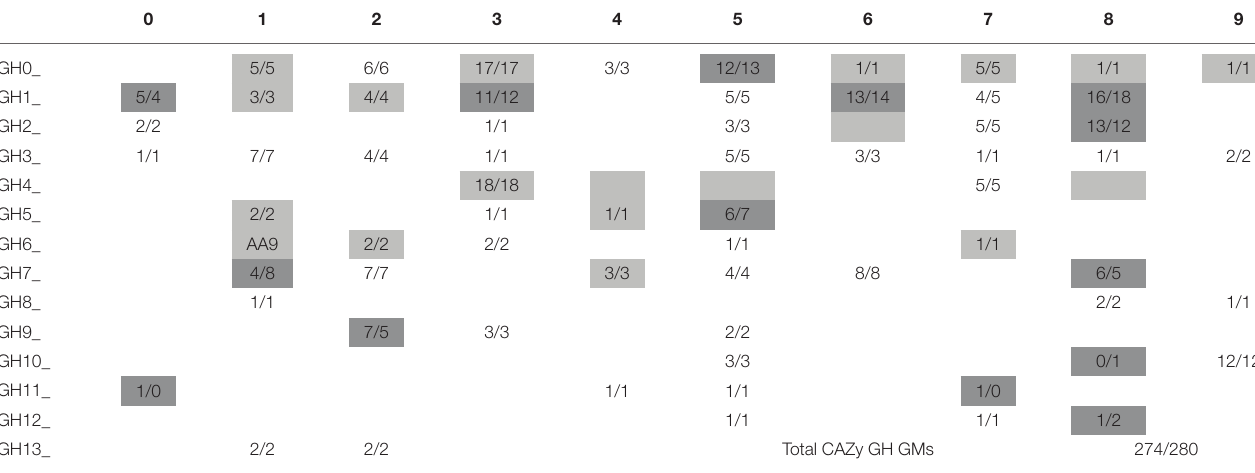
TABLE 7 | CAZy glycosyl hydrolase (GH) Inventory of AFUMN and A. fumigalus .